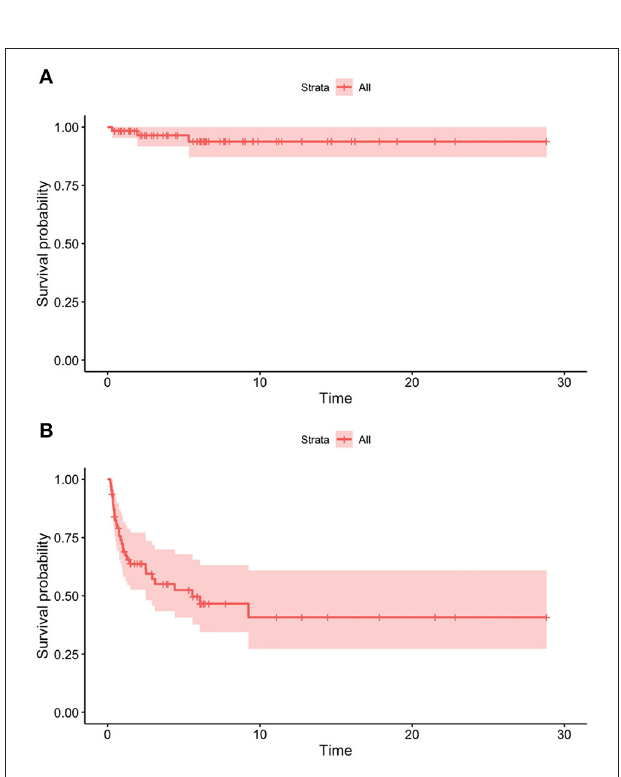
FIGURE 4 | Survival (A) and dependence (B) rates of patients on HPN because of primary CIF.